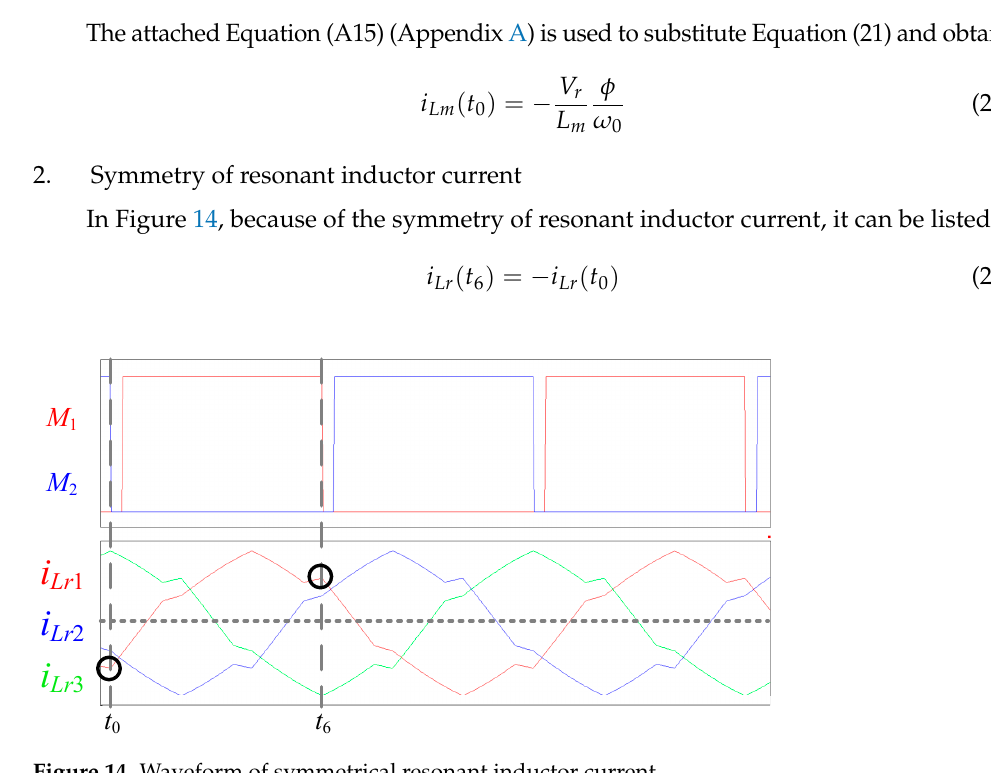
Figure 14. Waveform of symmetrical resonant inductor current.